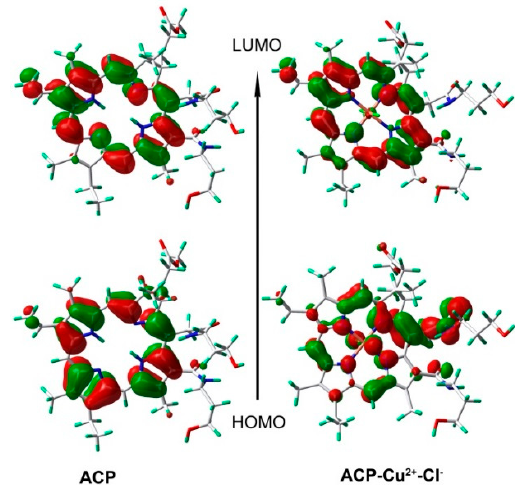
Figure 7. Frontier molecular orbitals of ACP and ACP -Cu 2+ complex (1:1) obtained at B3LYP/6-31G(d, p) and B3LYP/LANL2DZ level, respectively.